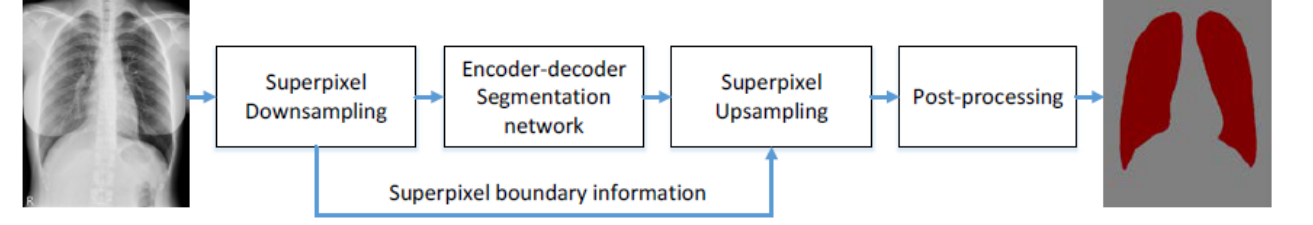
Figure 4. Overview of the proposed lung field segmentation method.